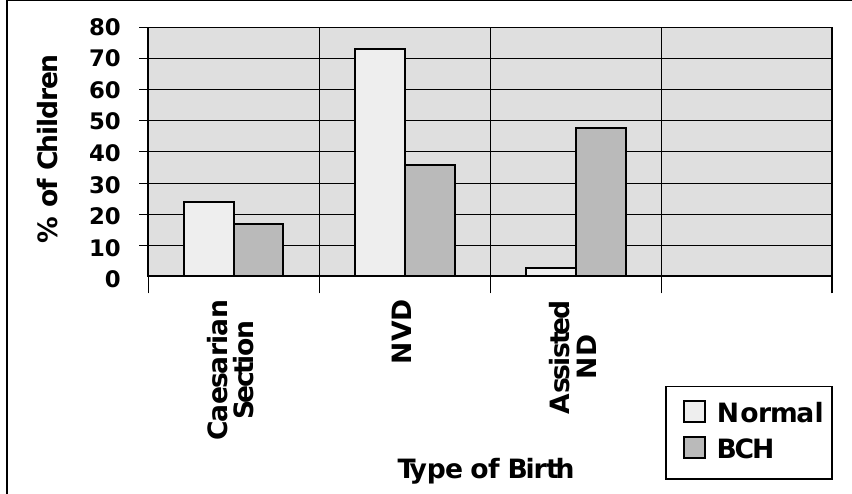
Figure 1: Comparison of Birth History of normal children (n=280) and those testing positive for “BCH” (n=95).